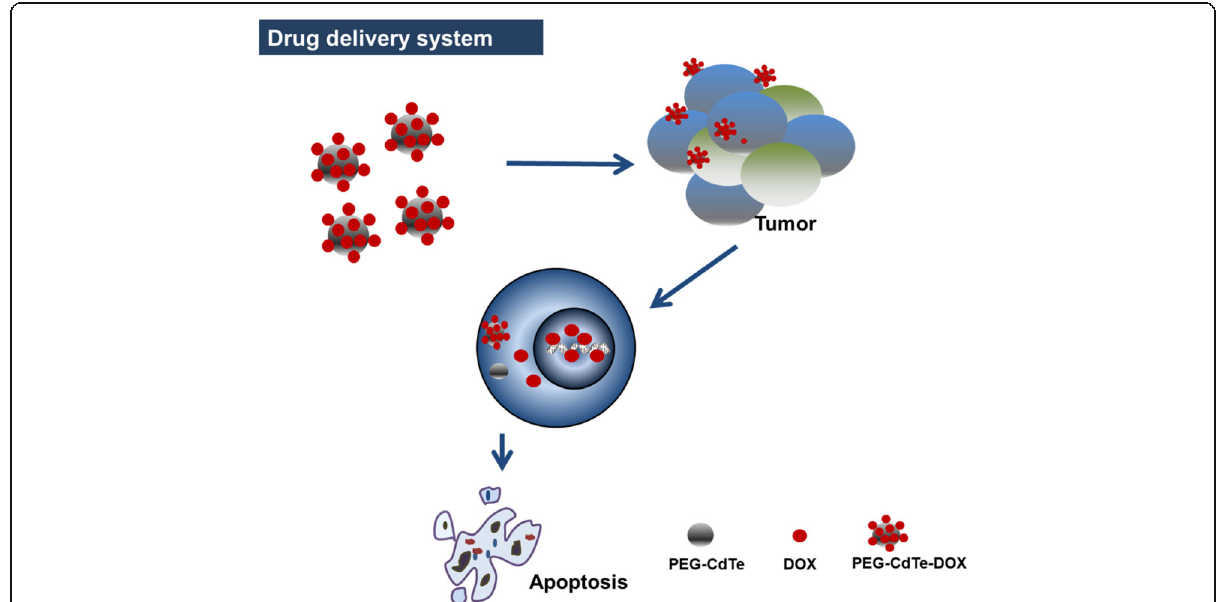
Fig. 1 Schematic illustration of possible mechanism of improved anti-tumor activity of PEG-CdTe-DOX in vitro. Notes: they can be internalized when targeting tumor cells through high tissue compatibility of PEG. DOX induces tumor cell apoptosis through regulating the expression of apoptosis-associated